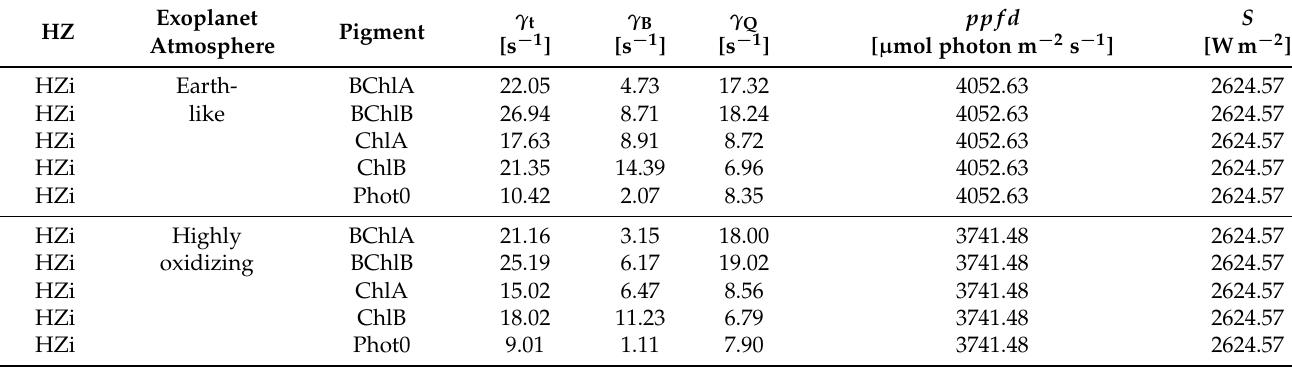
Table A3. Photosynthetic fitness metrics for Earth-like exoplanets with different atmospheres at different separations (HZi, HZm, HZo) around a G2V